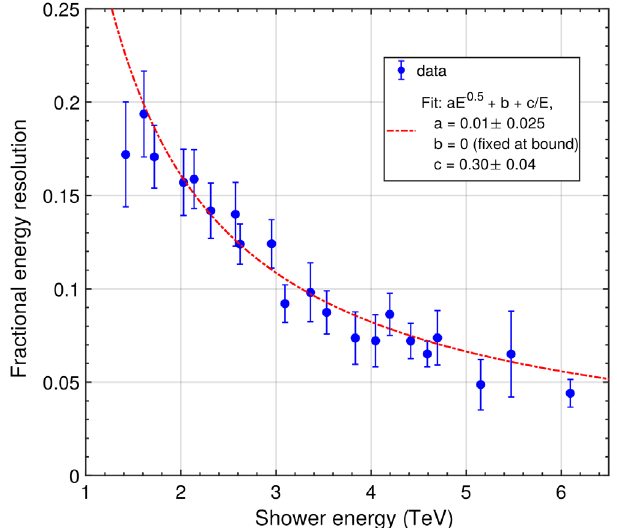
FIG. 12. Scatter plot of the SNR of the phase-aligned sum of the CCFs for all three ACE elements, along with a fit and extrapo- lation to the threshold energy. These results are from about 1000 events taken during the low beam-current 12.16 GeV runs with the full tungsten radiator load in place.